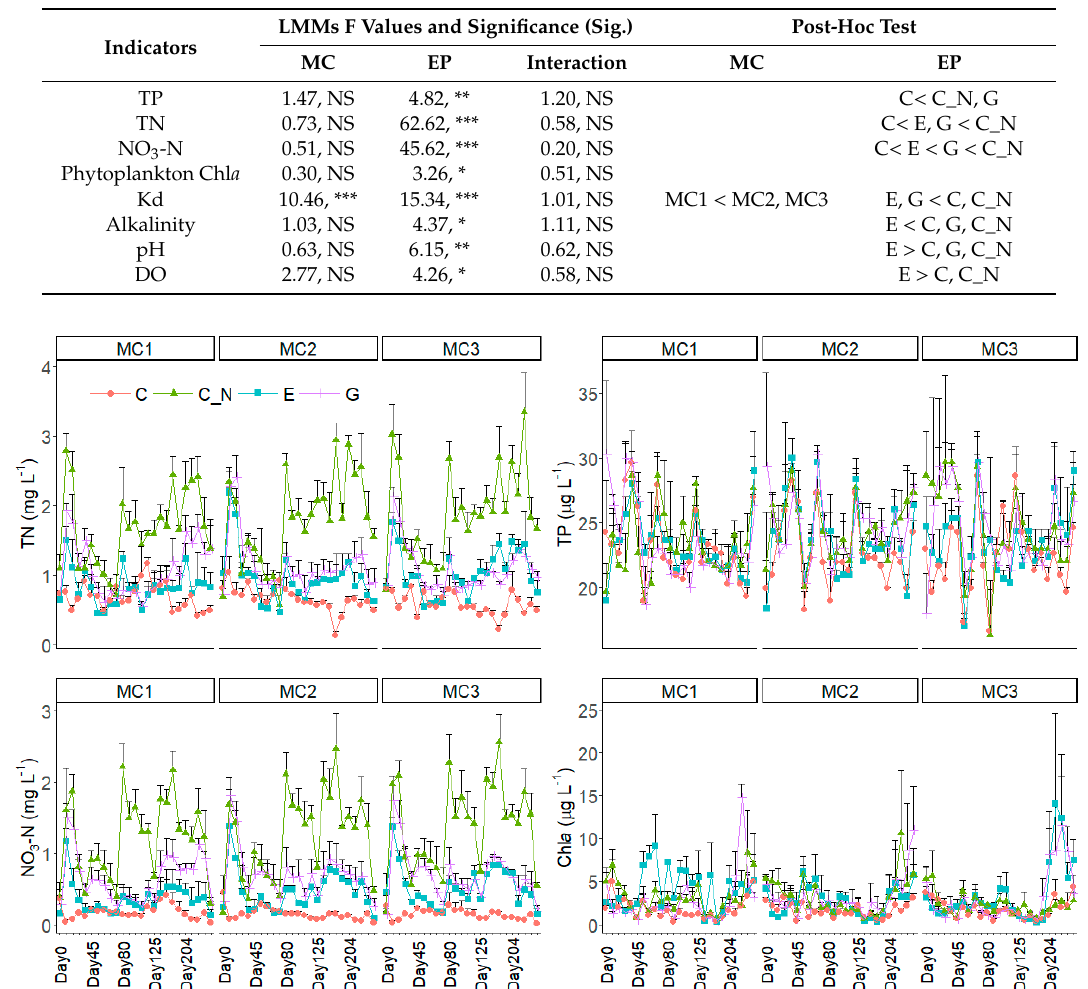
Figure 1. The changes in physico-chemical parameters (mean + SD) including total nitrogen (TN), total phosphorus (TP), nitrate (NO 3 -N) and phytoplankton chlorophyll a (Chl a ) during the experiment for the three macrophyte community treatments (MC1, MC2 and MC3) and the four extreme precipitation treatments (EP: C, C_N, E and G). For clarity, SD values are only shown in one